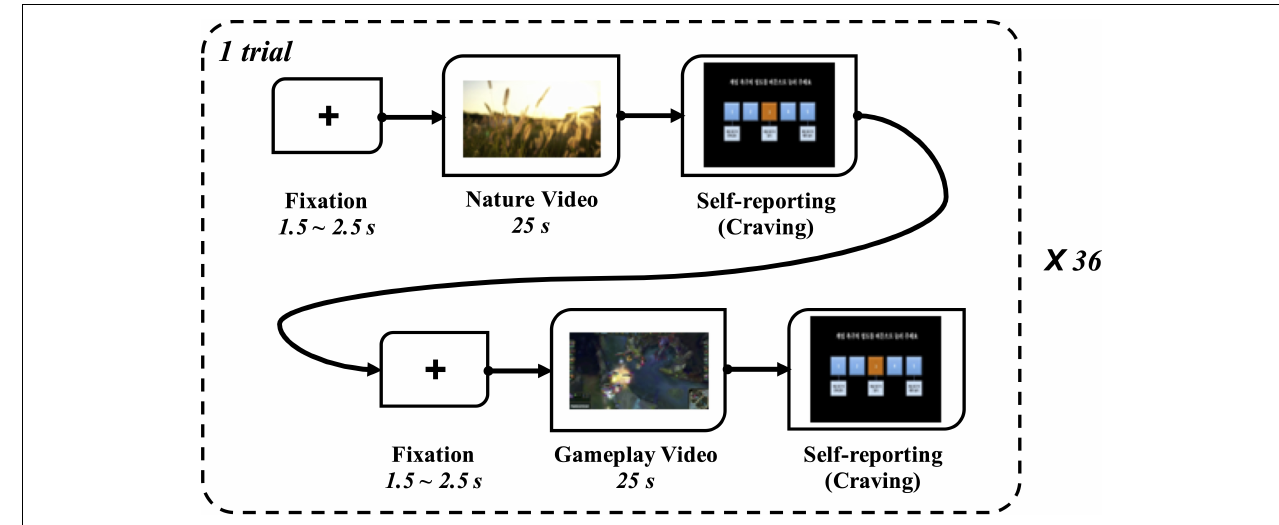
FIGURE 1 | Schematic representation of the experimental